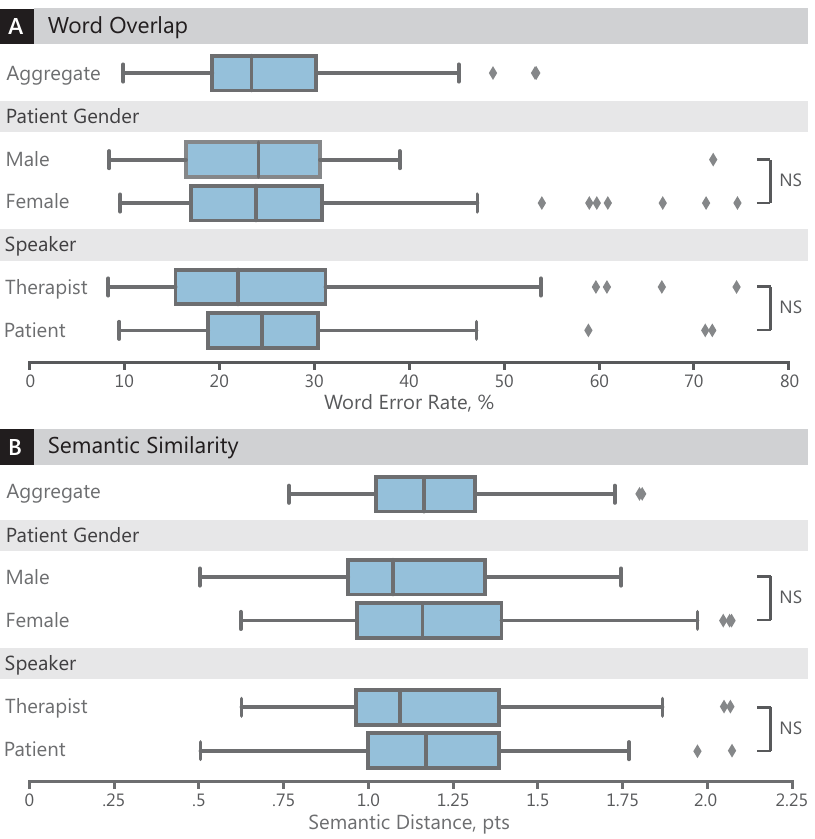
Fig. 1 Automatic speech recognition performance, overall and by subgroup. Evaluation of ASR transcription performance compared to the human-generated reference transcription. Each box denotes the 25th and 75th percentile. Box center-lines denote the median. Whiskers denote the minimum and maximum values, excluding any outliers. Outliers, denoted by diamonds, are de fi ned as any point further than 1.5× the interquartile range from the 25th or 75th percentile. Sample sizes are listed in Table 2. NS not signi fi cant means the difference is not